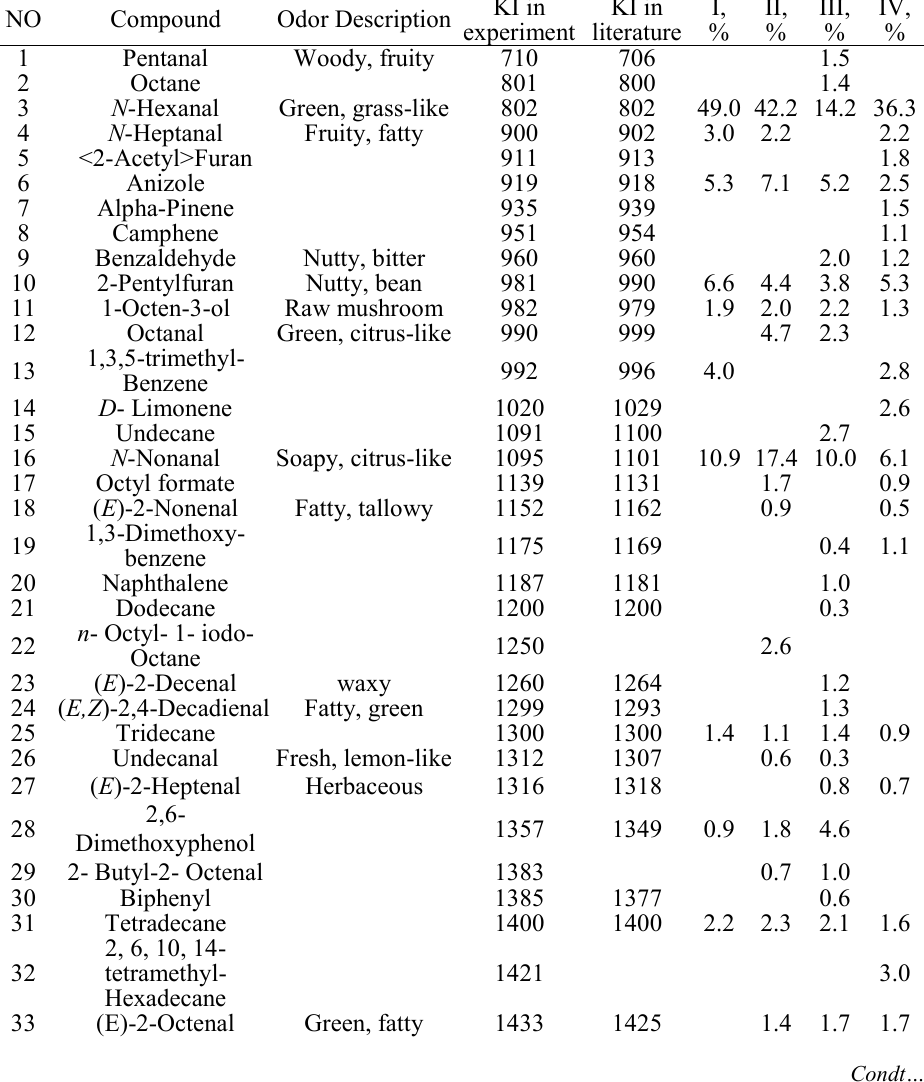
Table 3. Flavor volatiles identified in the headspace of HD6 rice